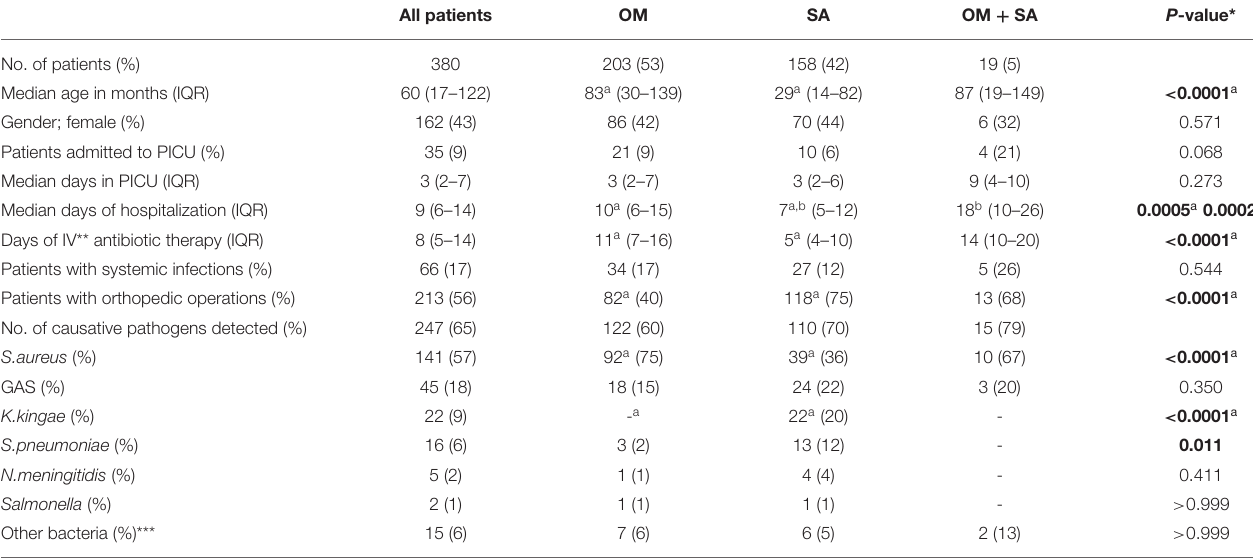
TABLE 1 | Characteristics of patients with bone and joint infections. All patients OM